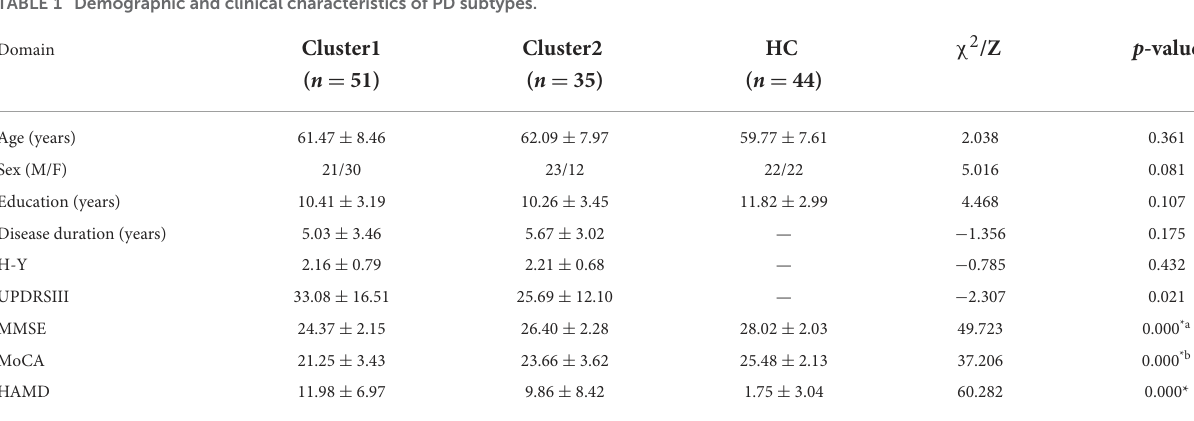
TABLE 1 Demographic and clinical characteristics of PD